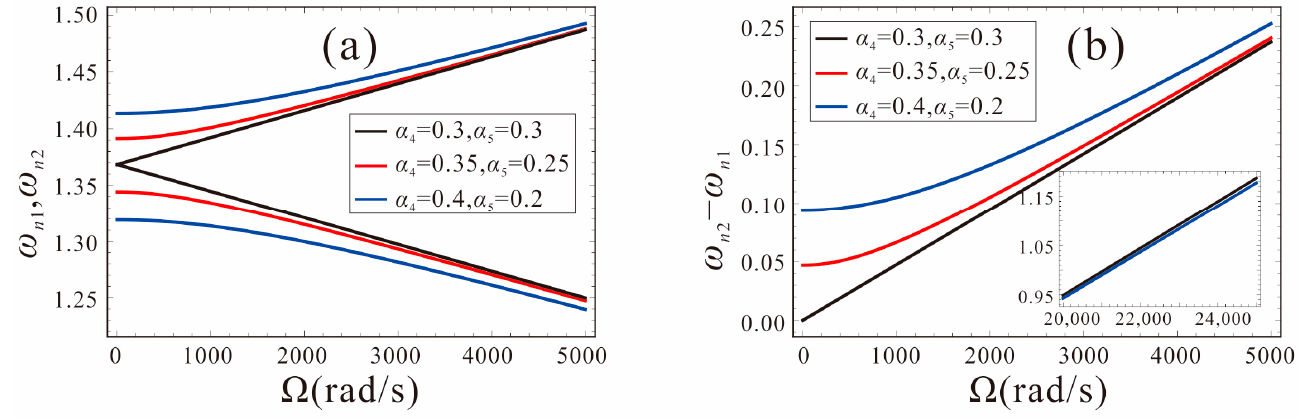
Figure 10. Effects of angular velocity on the natural frequency for the case of different shape factors. Table 2. Angular gain factors for FM micro-gyroscope with different shape factors.